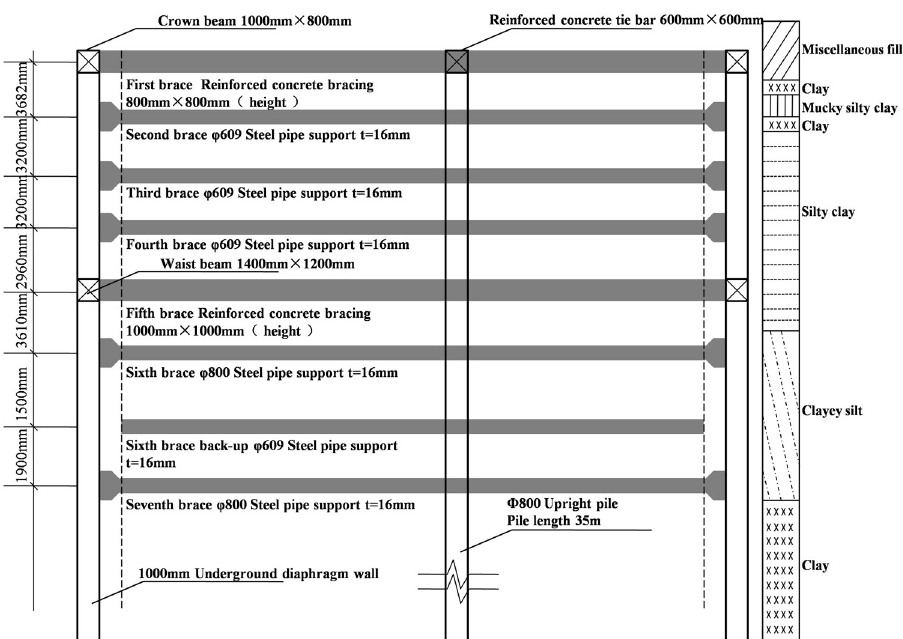
Fig 3. Cross-section drawing of the main